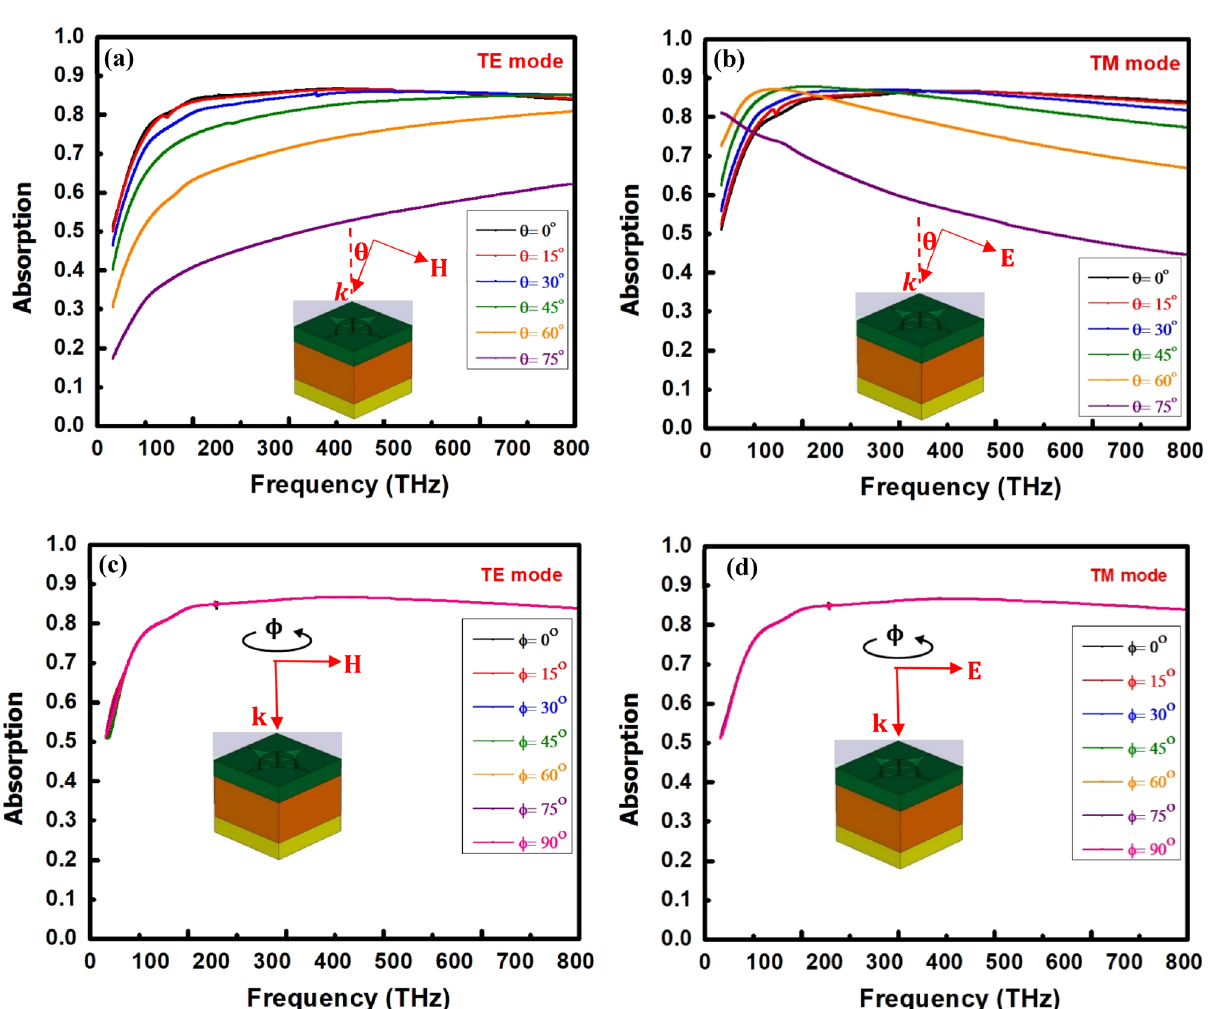
Figure 7. Simulated absorption spectra of the proposed antenna with different incidence angles θ ranging from 0 o to 75 o for ( a ) TE mode and ( b ) TM mode. TE and TM incident waves impinge on the absorber structure in x–z incident plane. Simulated absorption spectra of the proposed antenna for polarization angles ϕ ranging from 0 o to 90 o for ( c ) TE mode and ( d ) TM